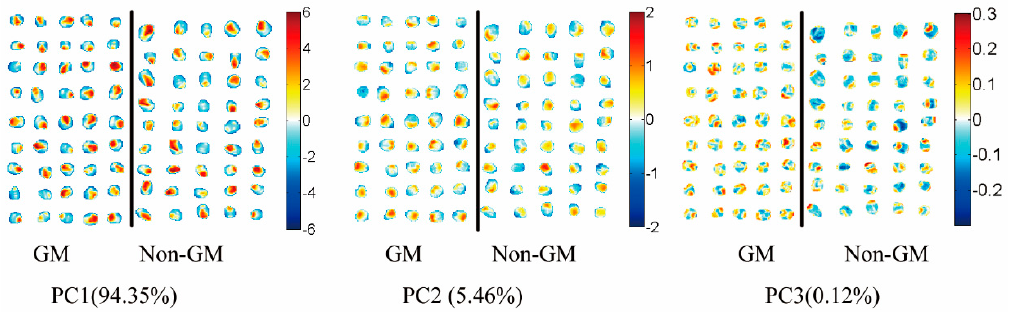
Figure 5. Score images of the first three principal components ( PC1 – PC3 ) of the images of maize kernels.